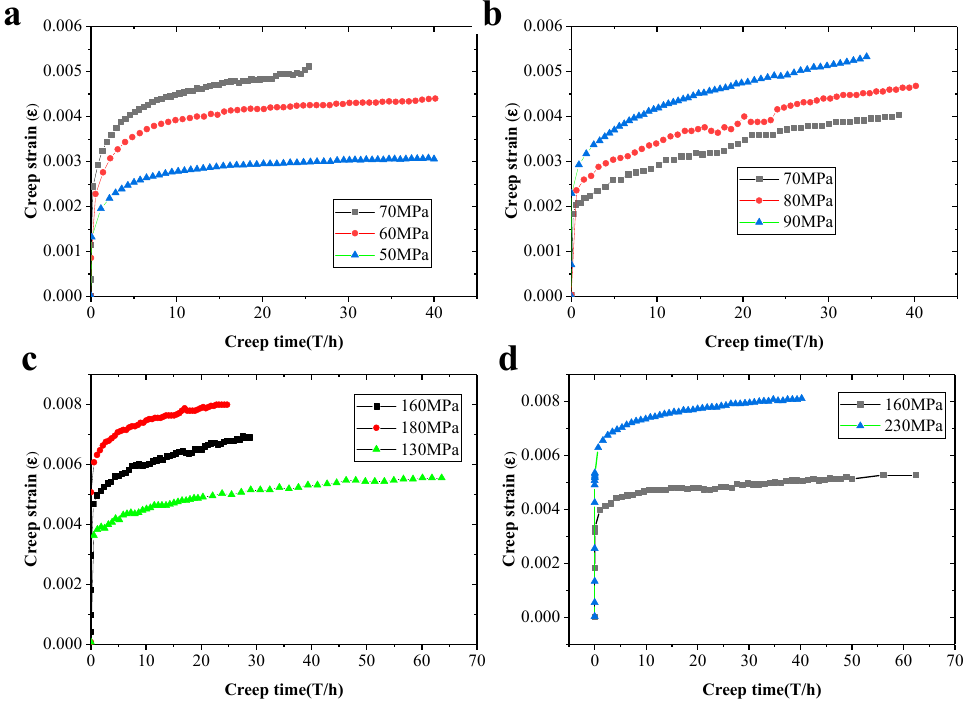
Figure 4. Tensile creep curves for the ABOw/Al–12Si composites tested at 400 °C ( a ), 350 °C ( b ), 300 °C ( c ), and 250 °C ( d ).